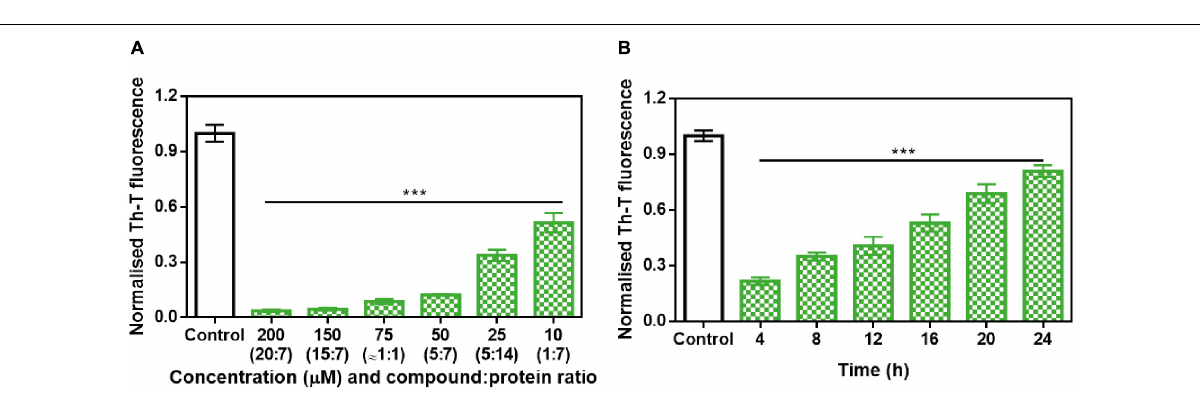
protein is already decreased in treated samples at passes 1–3 ( Supplementary Figure S3